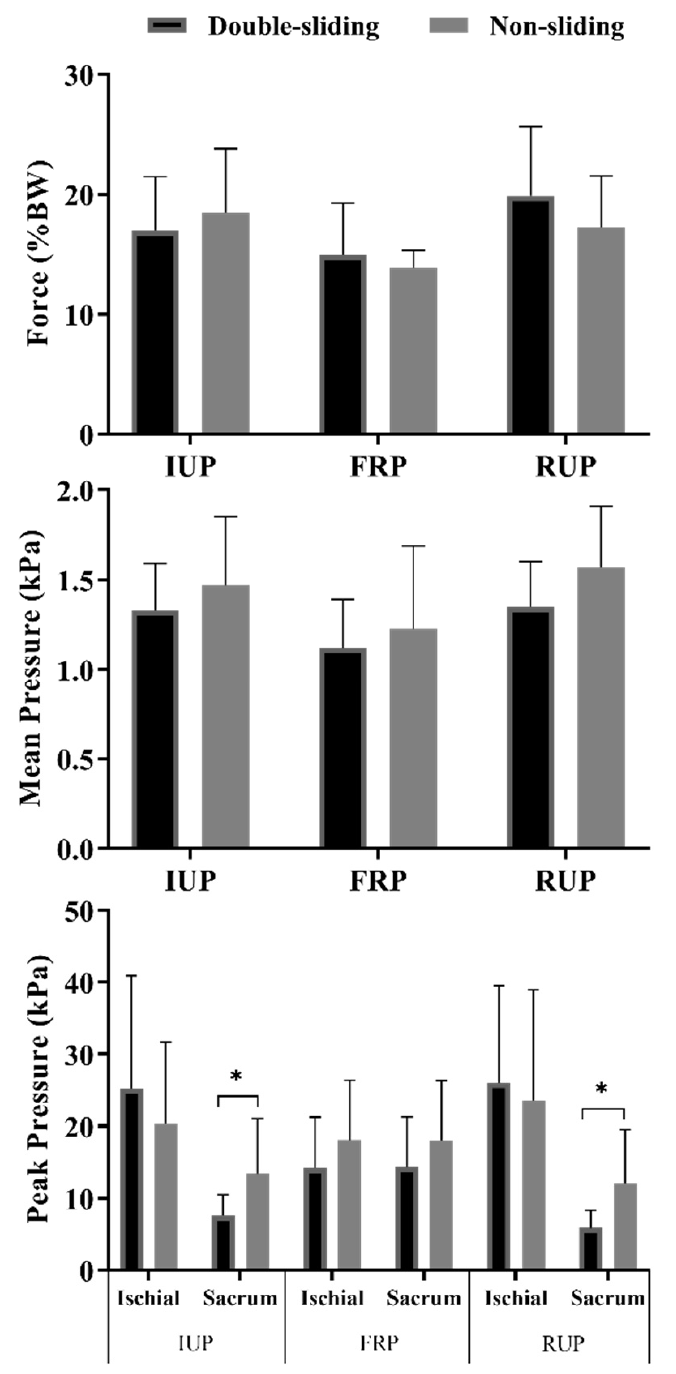
Figure 5. Comparison chart of buttock pressure between double-sliding and non-sliding in IUP, FRP, and RUP. (IUP, initial upright position; FRP, fully reclined position; RUP, return upright position; *, buttock pressure description section).